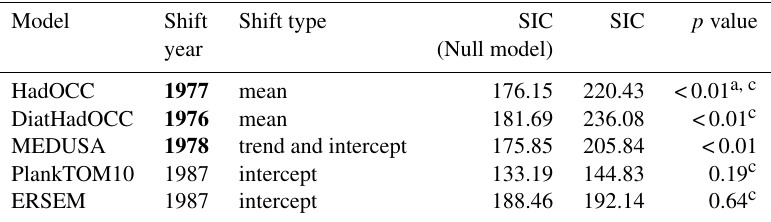
Table A1. Results from change-point detection analysis on the first principal component (PC1) of each model. Years in bold have a significant shift ( p value<0.05).